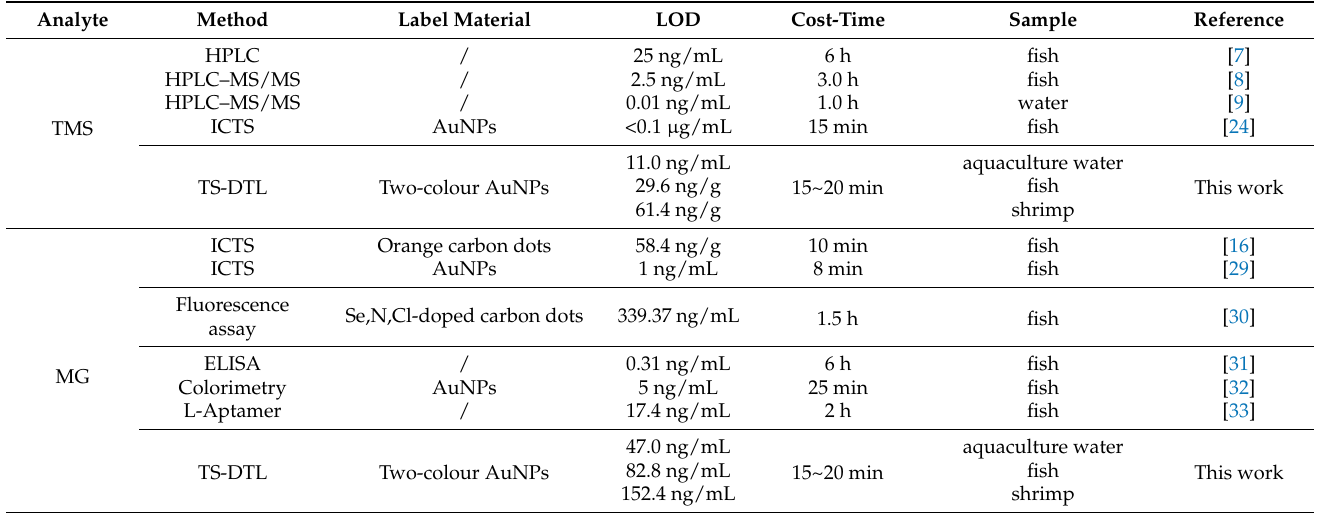
Table 1. Comparison of various methods for the quantitative detection of TMS and MG.